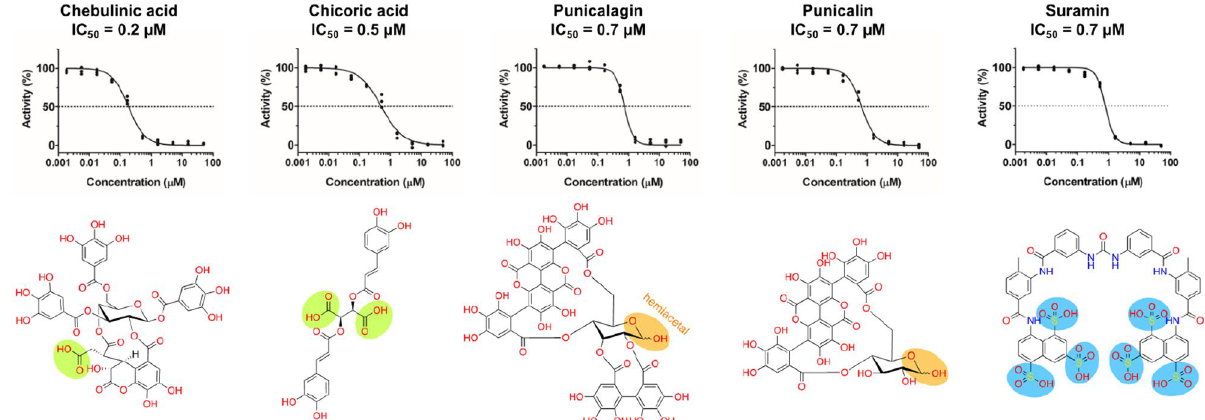
Figure 2. Concentration–response curves and chemical structures of compounds identified as submicromolar N-protein-RNA1 disruptors in the HTS trials. Curves were measured in triplicates, normalized to positive and negative controls and fitted with the log 4-parameter curve in GraphPad Prism. The main non-phenolic functional groups were highlighted as follows: carboxylic acids (green); hemiacetal—in equilibrium with the aldehyde form—(orange); as well as the sulfonic acids (blue) for the polyamide